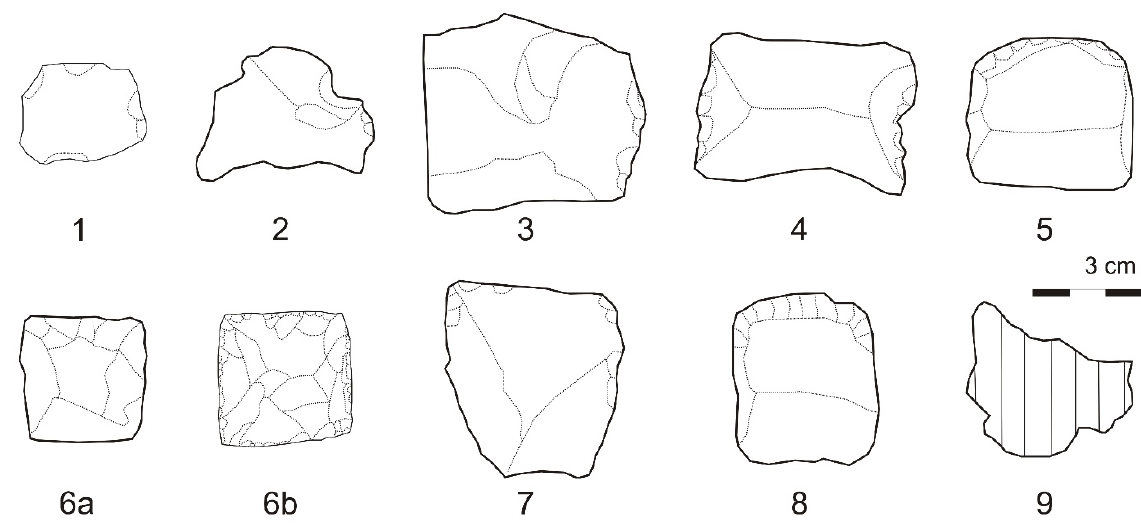
Figure 5. Different morphologies and types of gunflints. Based on Merino (1965) and Barandiarán (1974).